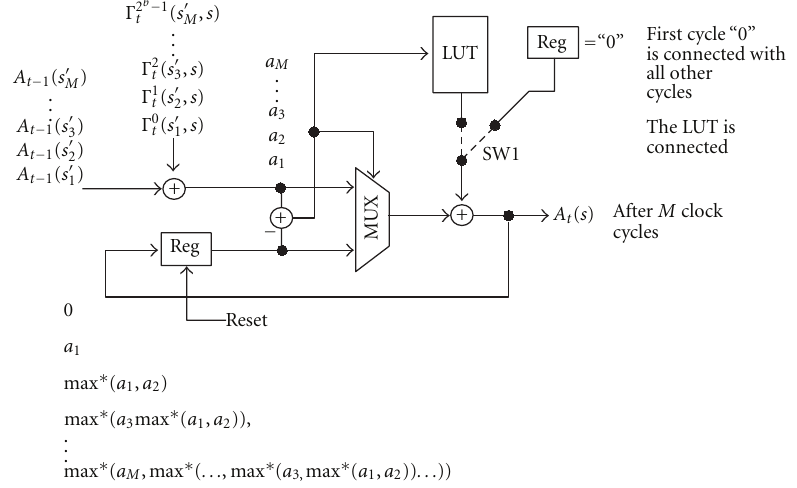
Figure 4: Recursive ACSO unit architecture.